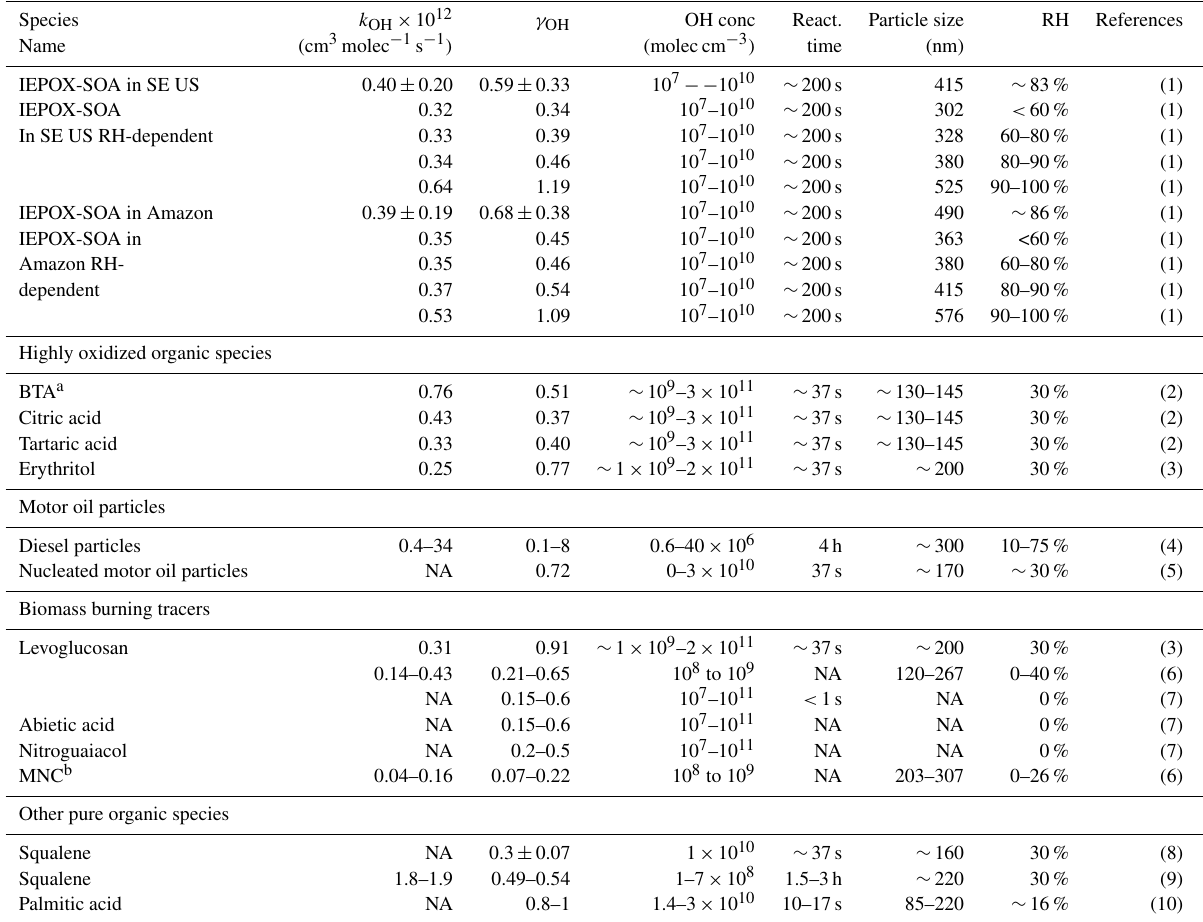
Table 1. Summary of k OH , γ OH and different experiment parameters used in this study and other lab studies. Species k OH × 10 12 γ OH OH conc React. Particle size